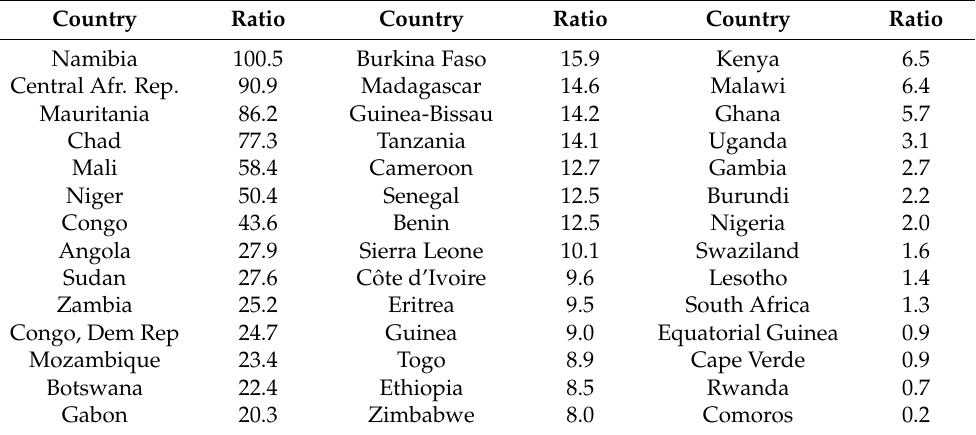
Table 1. Potential annual production of renewable energy relative to current annual domestic energy consumption for Sub-Saharan countries. A ratio of 1 corresponds to a configuration where the estimated potential equals the current energy consumption. Source: [23,26]. Country Ratio Country Ratio Country Ratio Namibia 100.5 Central Afr.